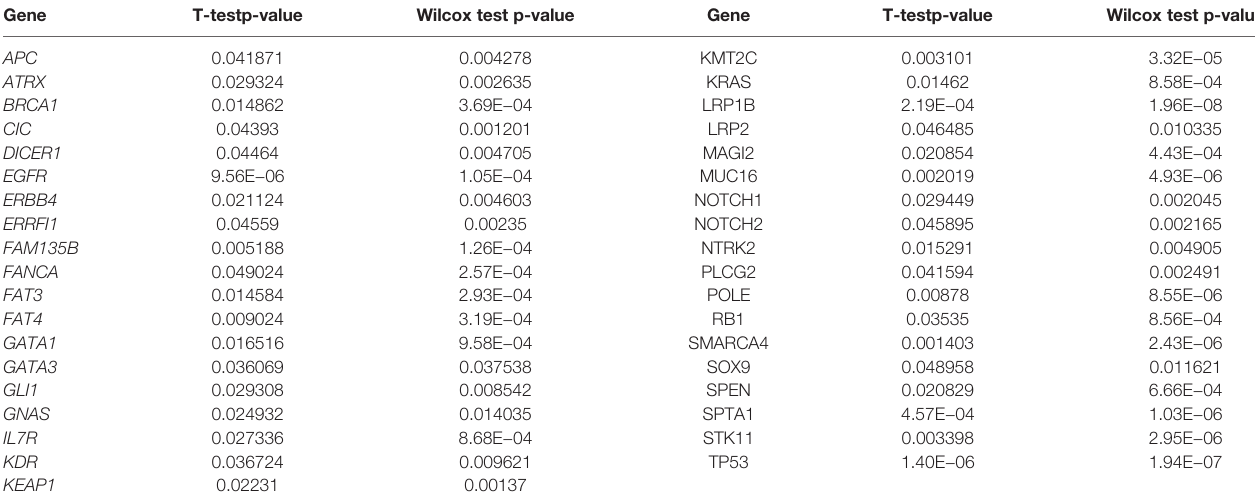
TABLE 2 | The mutated genes associated with TMB.